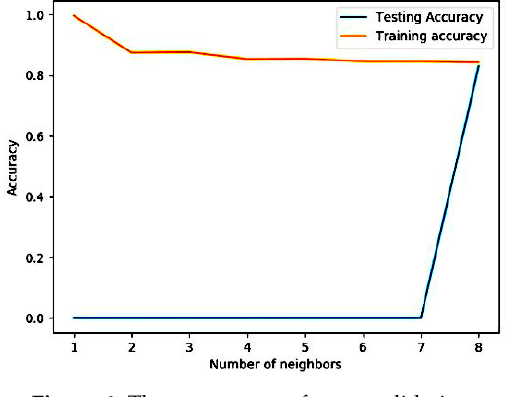
Figure 6. The correct rate of cross-validation.